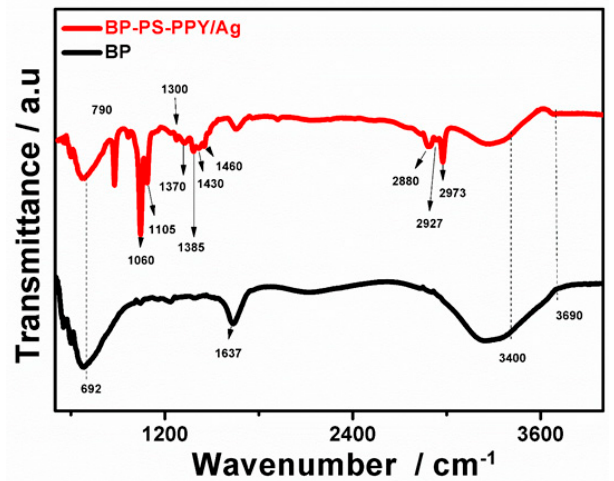
Figure 5. Fourier transformed infrared spectra (FTIR) analysis of typically prepared BP-Ps-PPy/Ag nanocomposite and BP.